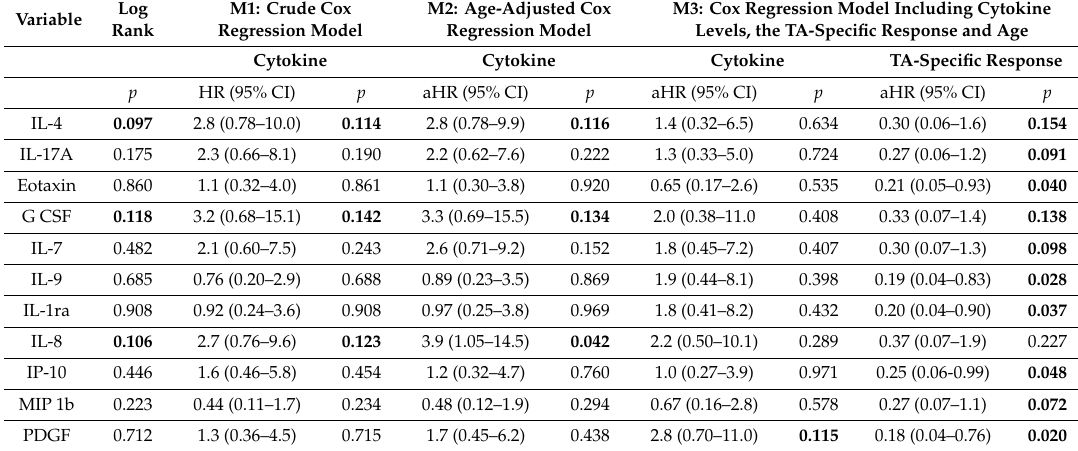
Table 4. Association between serum cytokine levels (dichotomized) and RFS. Log rank test of the survival analysis and HRs with 95% CIs from Cox regression models. Model 1 (M1): crude model; model 2 (M2): age-adjusted model; model 3 (M3): addition of the TA-specific response.